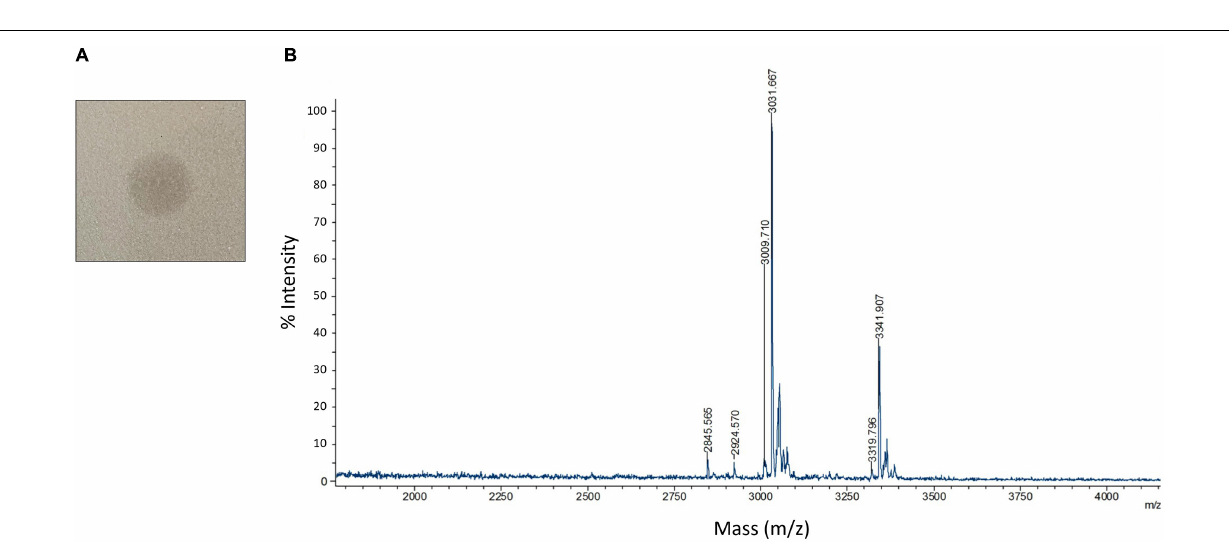
FIGURE 5 | Detection and characterization of HPLC purified AMPs (A) HPLC purified AMP from C3 extracts was spotted on a confluent lawn of B. subtilis and displays a zone of growth inhibition. (B) MALDI-TOF detection of HPLC purified AMP digested by leucine aminopeptidase for 40 mins at 37 ◦ C. Peaks are labeled with m/z